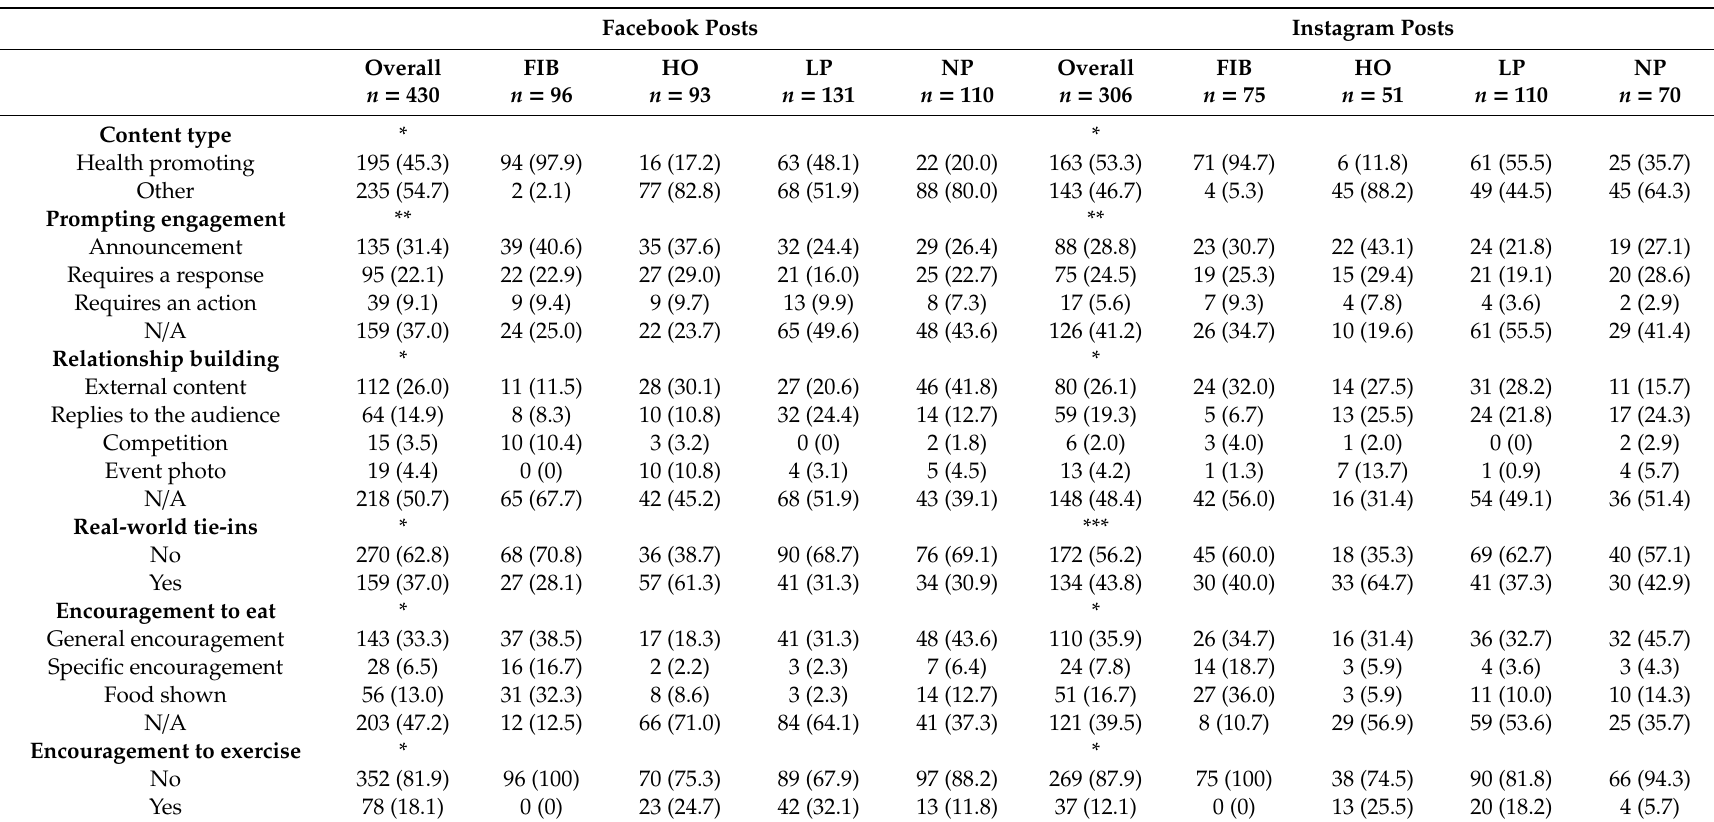
Table A2. Frequency of objective social media strategies used by the fields across Facebook and Instagram. All values are presented as n